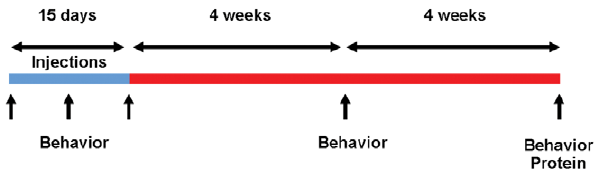
locomotion and performance on the rotarod. Blue: acute toxicity period. Red: recovery